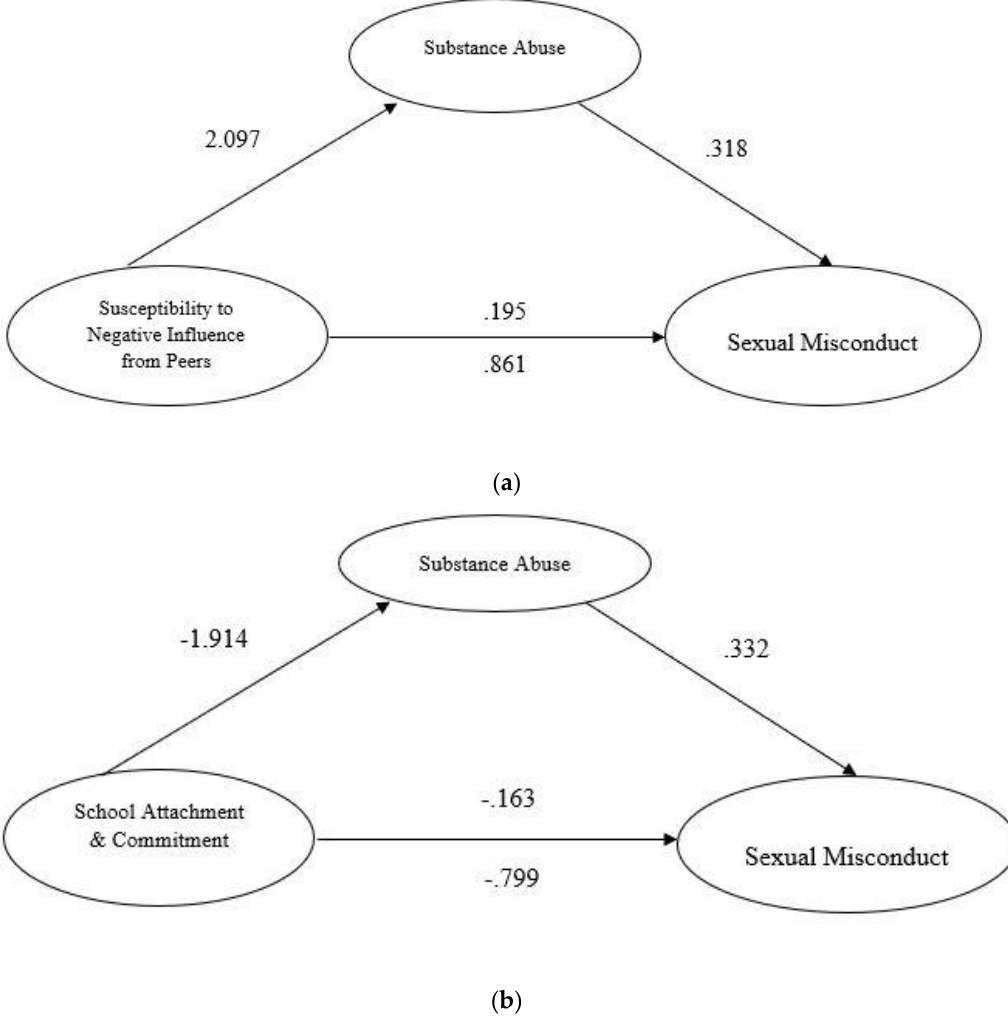
Figure 2. ( a ) Mediating model of substance abuse on the relationship between peer influence and sexual misconduct. ( b ) Mediating model of substance abuse on the relationship between school attachment and commitment and sexual misconduct.